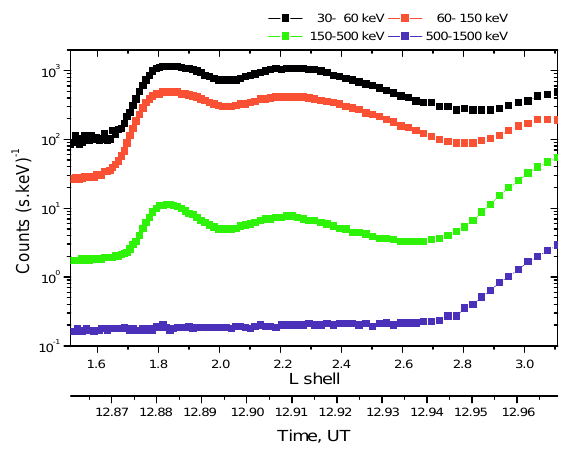
Fig. 3. X-ray counting rates versus L shell/time in four energy chan- nels measured by SONG during one passage (orbit on right, at lon- gitudes between − 75 ◦ and − 65 ◦ , rightmost panel of Fig. 2) of the CORONAS-F satellite on day 316 (12 November), the time being shown in hours, to two decimal places.